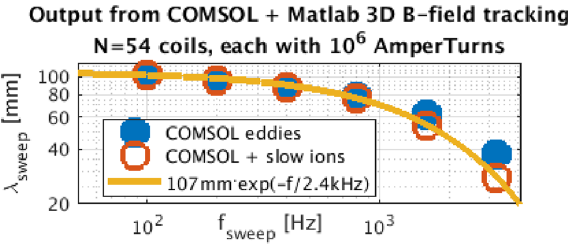
100 turns 54 coils (directly proportional), × ×